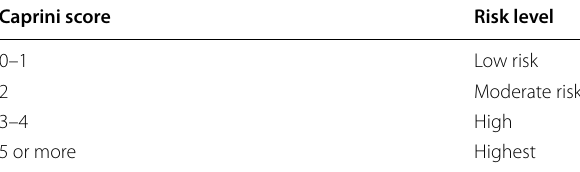
Table 1 Risk of post-operative VTE according to Caprini score